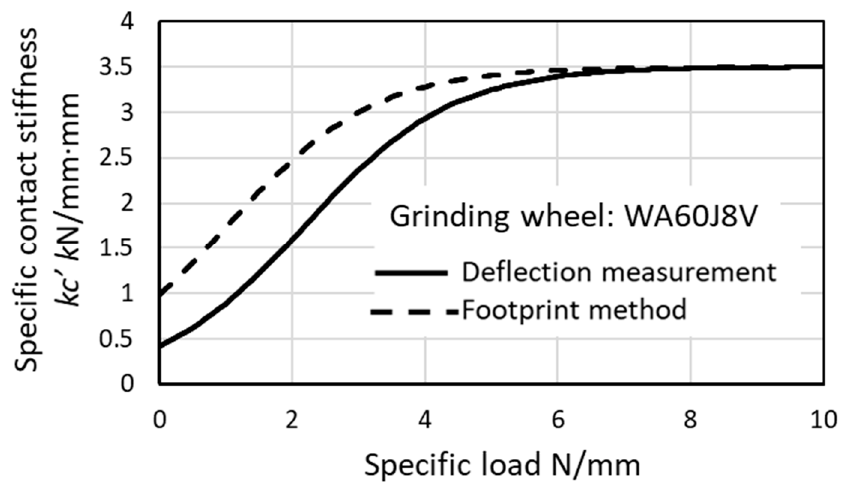
Figure 15. Specific contact stiffness of grinding wheel.